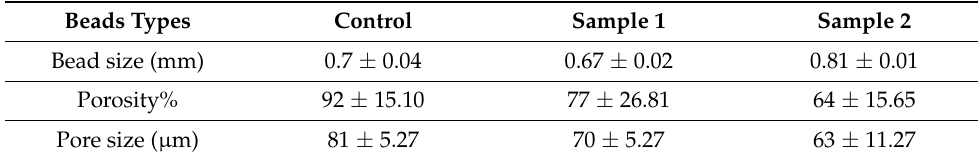
Figure 2. The ultrastructure of polymeric beads- ( A ) Macroscopic examination (by Vernier caliper in millimeters), ( B ) microscopic FESEM images at 1 kX (scale bar 500 µm), and ( C ) FTIR spectra of all the controlled and modified beads samples, respectively. Table 2. Beadssize, pore-size and porosity .